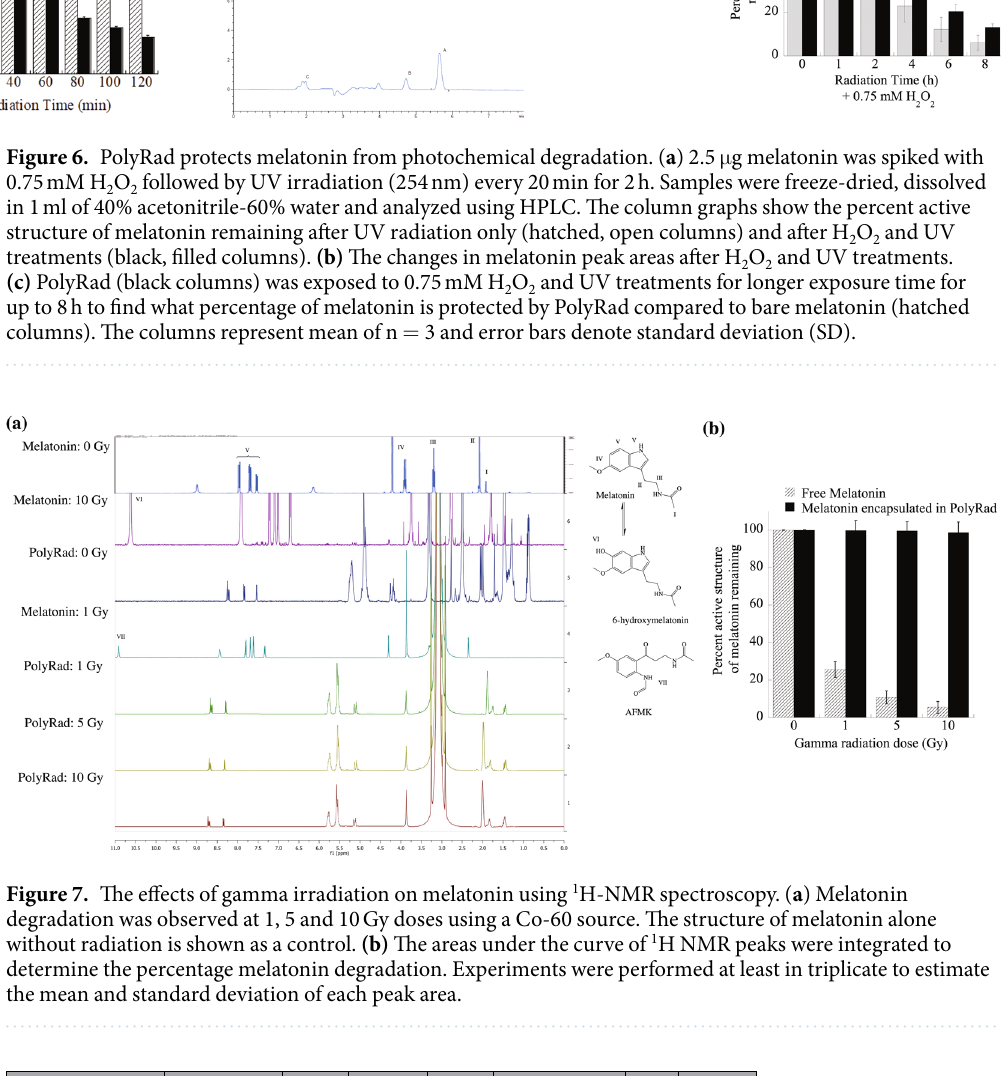
Peak center (ppm)